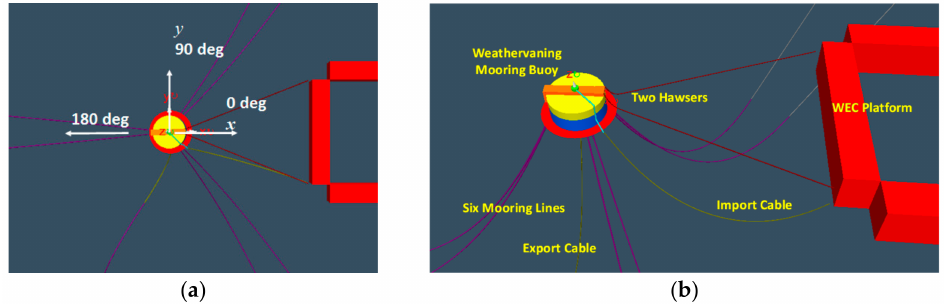
Figure 4. Numerical modeling: ( a ) coordinate system and heading definition; ( b ) perspective view of a numerical model for a coupled mooring analysis.